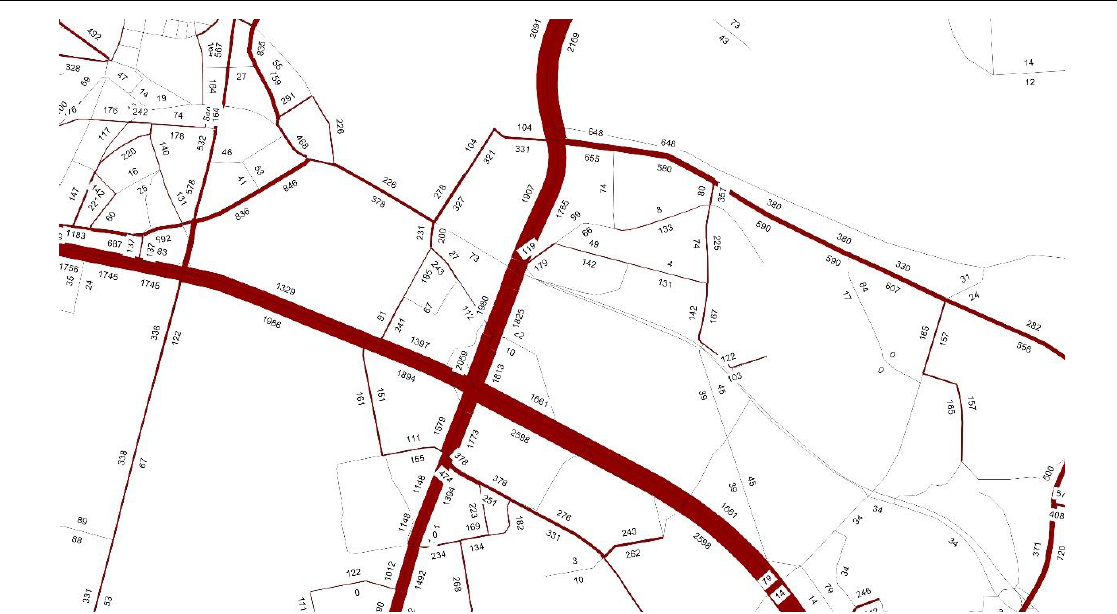
Fig. 2. Distribution of vehicle traffic in the analyzed area as it is in the afternoon peak